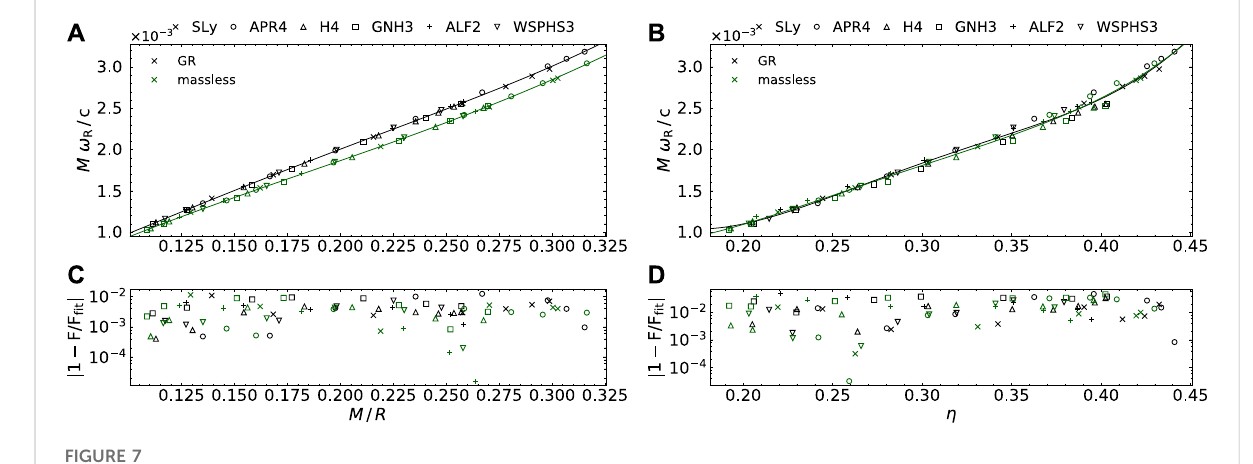
FIGURE 7 Dipole ϕ -mode universal relations: dimensionless frequency M ω R / c (A,B) and fi t errors (C,D) versus compactness C = M / R (A, C) and versus generalized compactness η (B,D) . The symbols indicate the respective equation of state, and the color green indicates the massless case, with the general relativistic case in black.